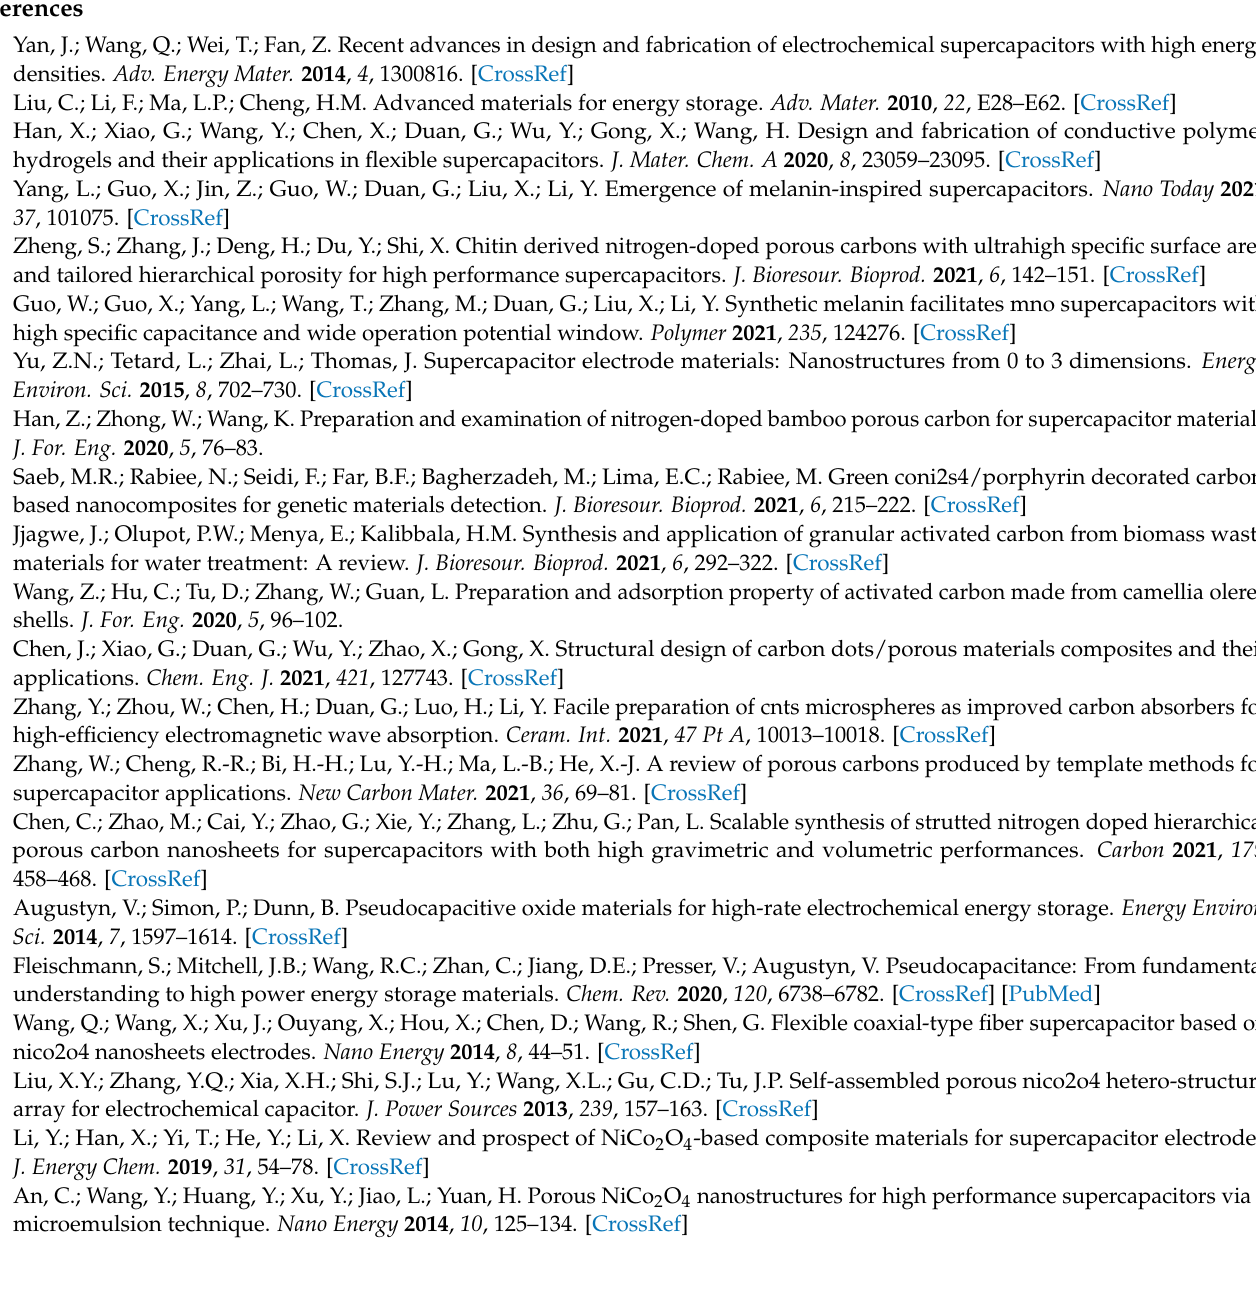
Figure S3: Electrochemical impedance spectra of NCW@NiCo 2 O 4 -x composite electrodes in a certain frequency range (0.01 Hz–10 kHz); Figure S4: Cycling performance of NCW//NCW@NiCo 2 O 4 at 10 A g − 1 ; Table S1: Mass loading of active